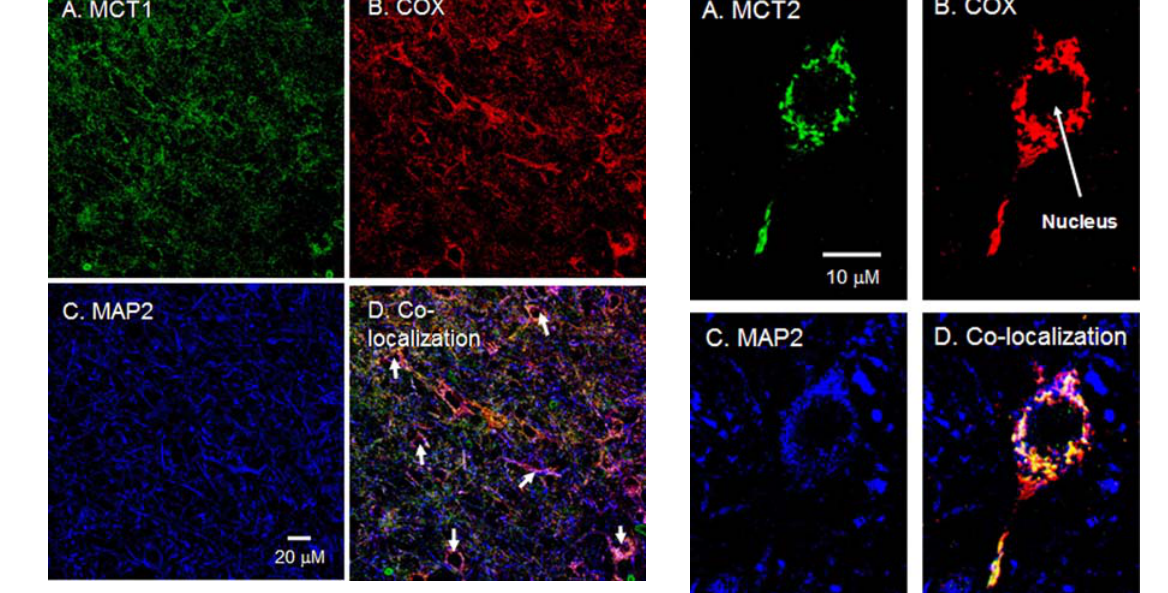
Figure 1. Immunohistochemical images of rat brain cross- sections demonstrating mitochondrial MCT1 in thalamic neurons. When signals from probes for the lactate/pyruvate trans- porter MCT1 (A, green) and mitochondrial cytochrome oxidase, COX (B, red) were merged with those of the neuronal marker MAP2 (C, blue), superposition of the signals (D, yellow/white) showed colocalization of MCT1 and components of the mitochondrial reticulum in neurons (white arrows). Scale bar=20 m m. doi:10.1371/journal.pone.0002915.g001 (Fig. 2D). Fig. 3 represents a neuron in CA2 of the hippocampus; at this larger magnification, the presence of MCT2 in the mitochondrial reticulum of a neuron is evident (Fig. 3D).